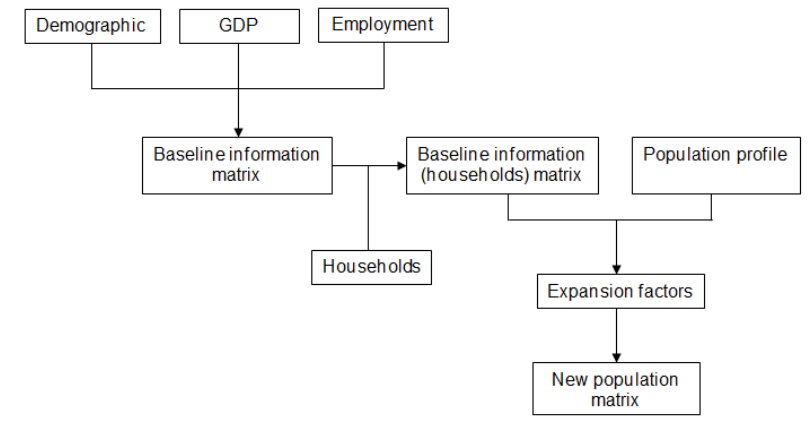
Figure 2. NTM forecast